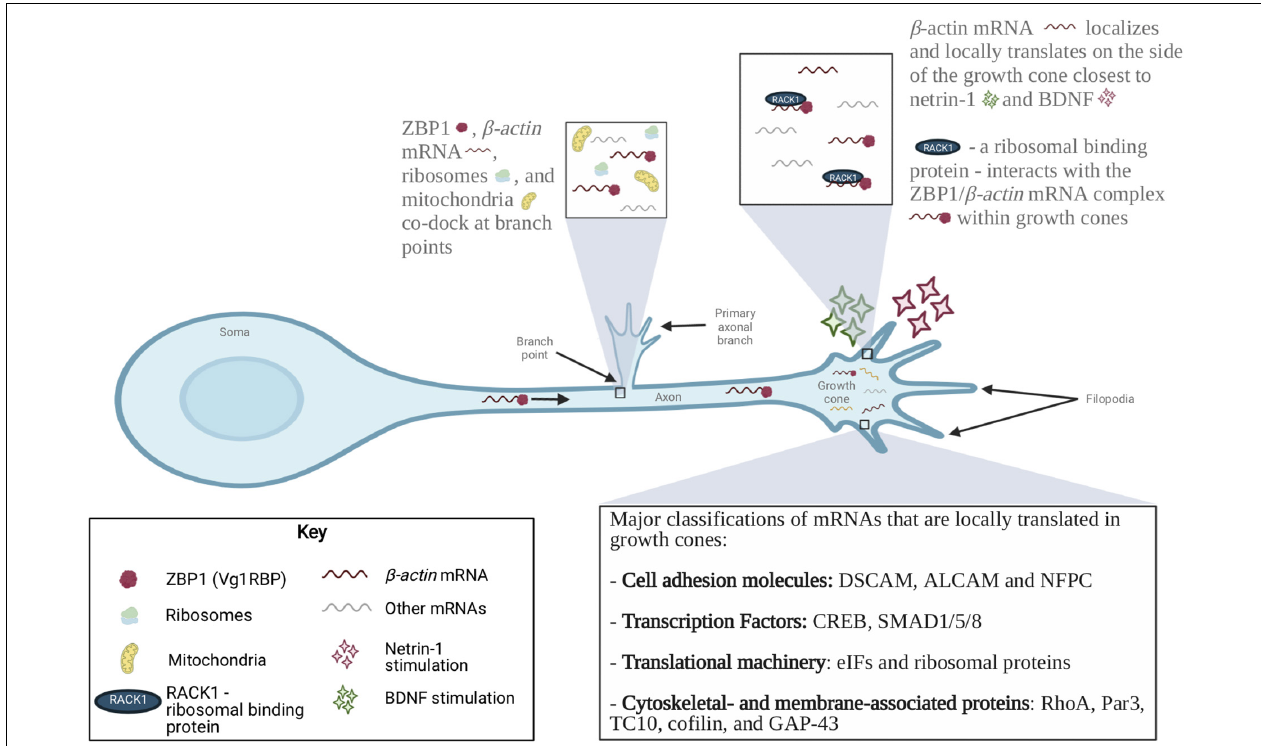
FIGURE 2 | Localization of mRNAs and RBPs in axons and growth cones during axon growth, guidance and branching. mRNAs localized to developing axons encode many functional classes of proteins, including cell adhesion molecules, guidance receptors, cytoskeletal components, and members of signaling cascades. The local translation complex of β -actin mRNA, ZBP1, ribosomes and mitochondria is involved in axon branching. BDNF and netrin-1 induced local translation of β -actin mRNA is also involved in axon guidance. Four major classes of mRNAs that are locally translated in growth cones are cell adhesion molecules, transcription factors, translational machinery and cytoskeletal- and membrane-associated proteins. The local translation of these proteins is a tightly regulated process that is critical for the formation of appropriate neural